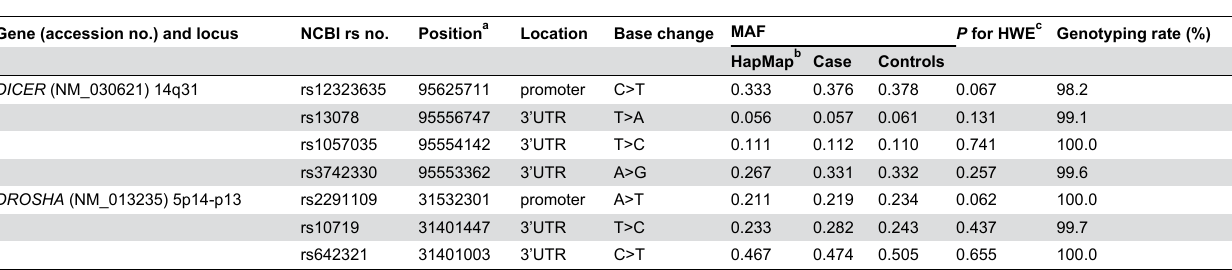
Table 1. Primary information of genotyped SNPs.